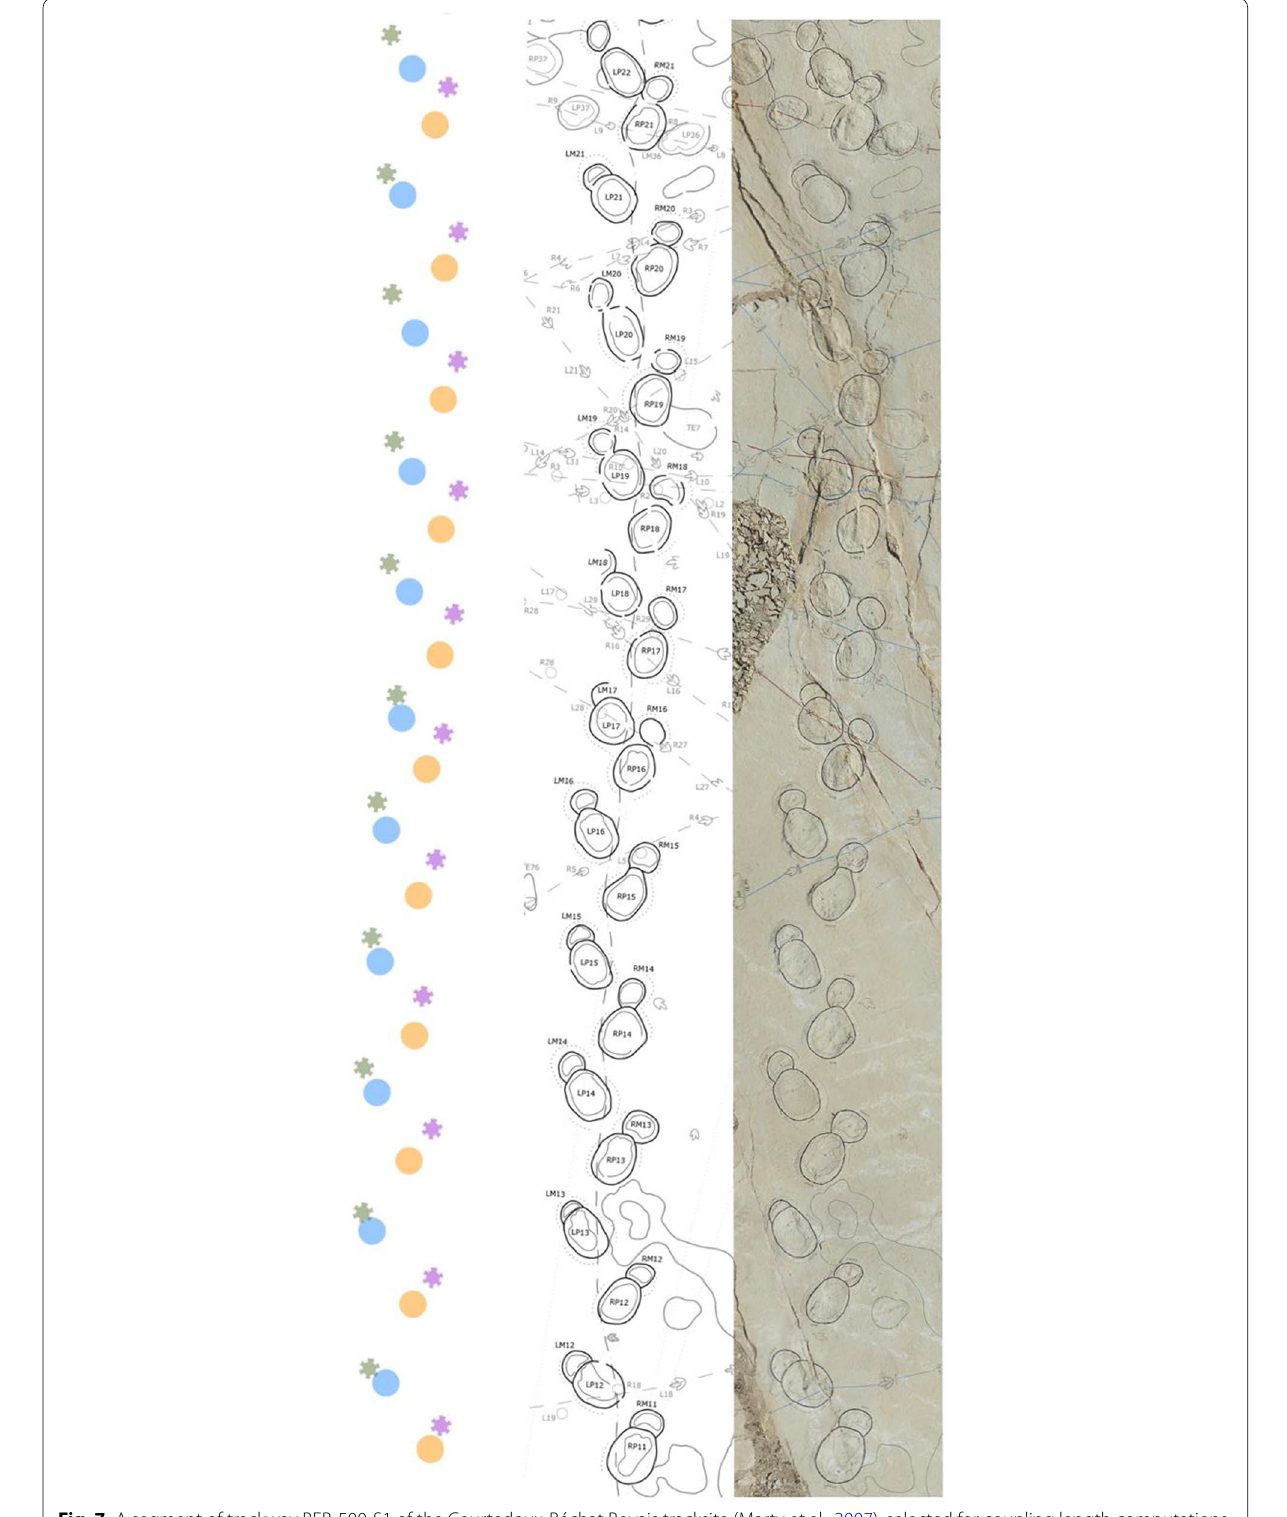
Fig. 7 A segment of trackway BEB-500-S1 of the Courtedoux-Béchat Bovais tracksite (Marty et al., 2007), selected for coupling length computations for various combinations of gait and duty factor. While substantially straight and regular, the trackway shows gradual variations in stride length. All tracks are very well preserved, with location uncertainties of only a few cm. The top row shows the S1 trackway segment for this